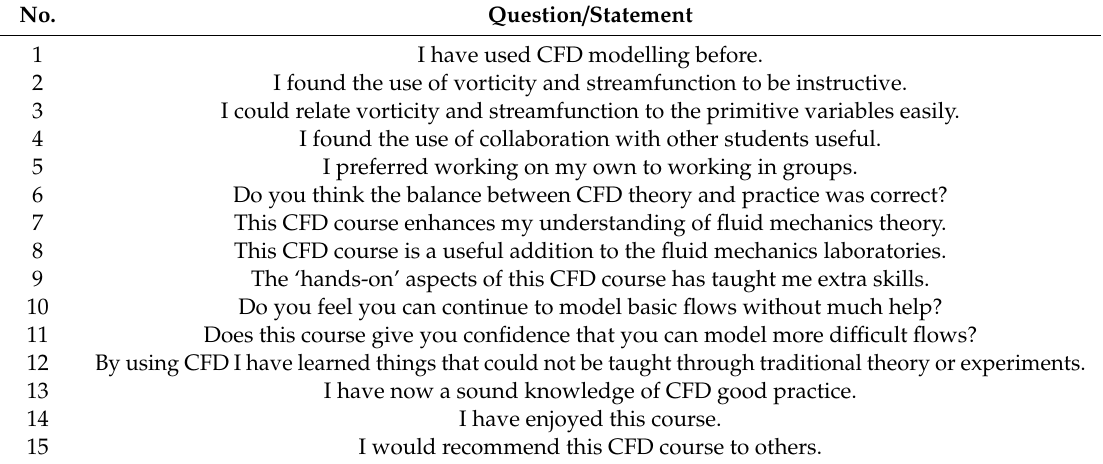
Table 2. A list of questions / statements used in the survey for students’